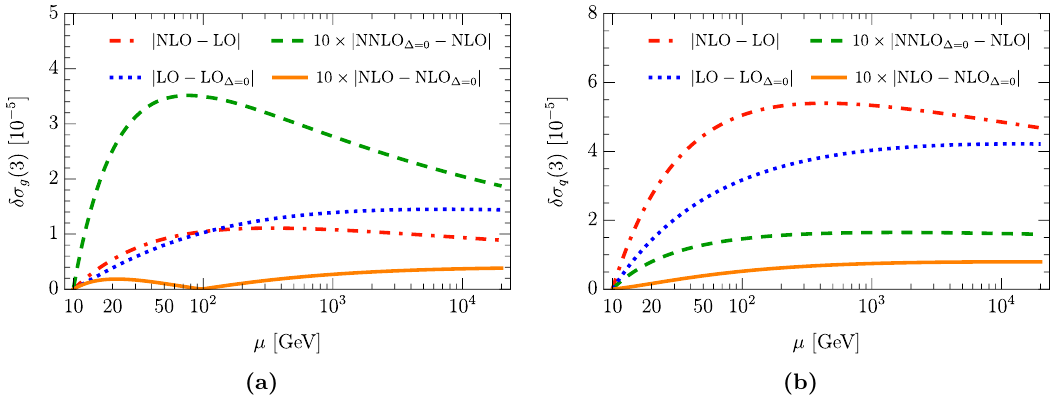
Figure 3. The difference in renormalization group evolution for (a) σ g (3) and for (b) σ q (3) for the initial conditions in (5.2). Shown are the effect of the ∆ terms at LO (blue dotted), NLO (orange solid), the effect of the NLO evolution (red dot-dashed) and the NNLO evolution (green dashed). Note that two curves are multiplied by 10 for better